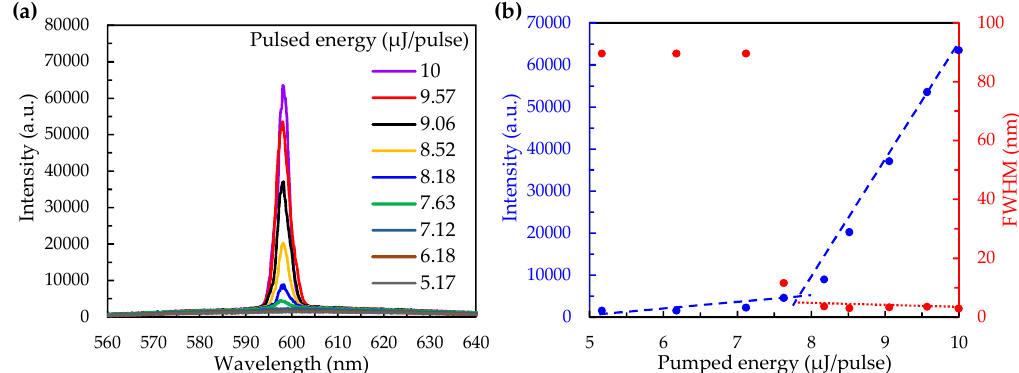
Figure 4. ( a ) The change of the pumping energy on the lasing spectra of the colloidal-crystal laser; ( b ) The pumping energy dependent intensity and FWHM of lasing on the pulsed laser.